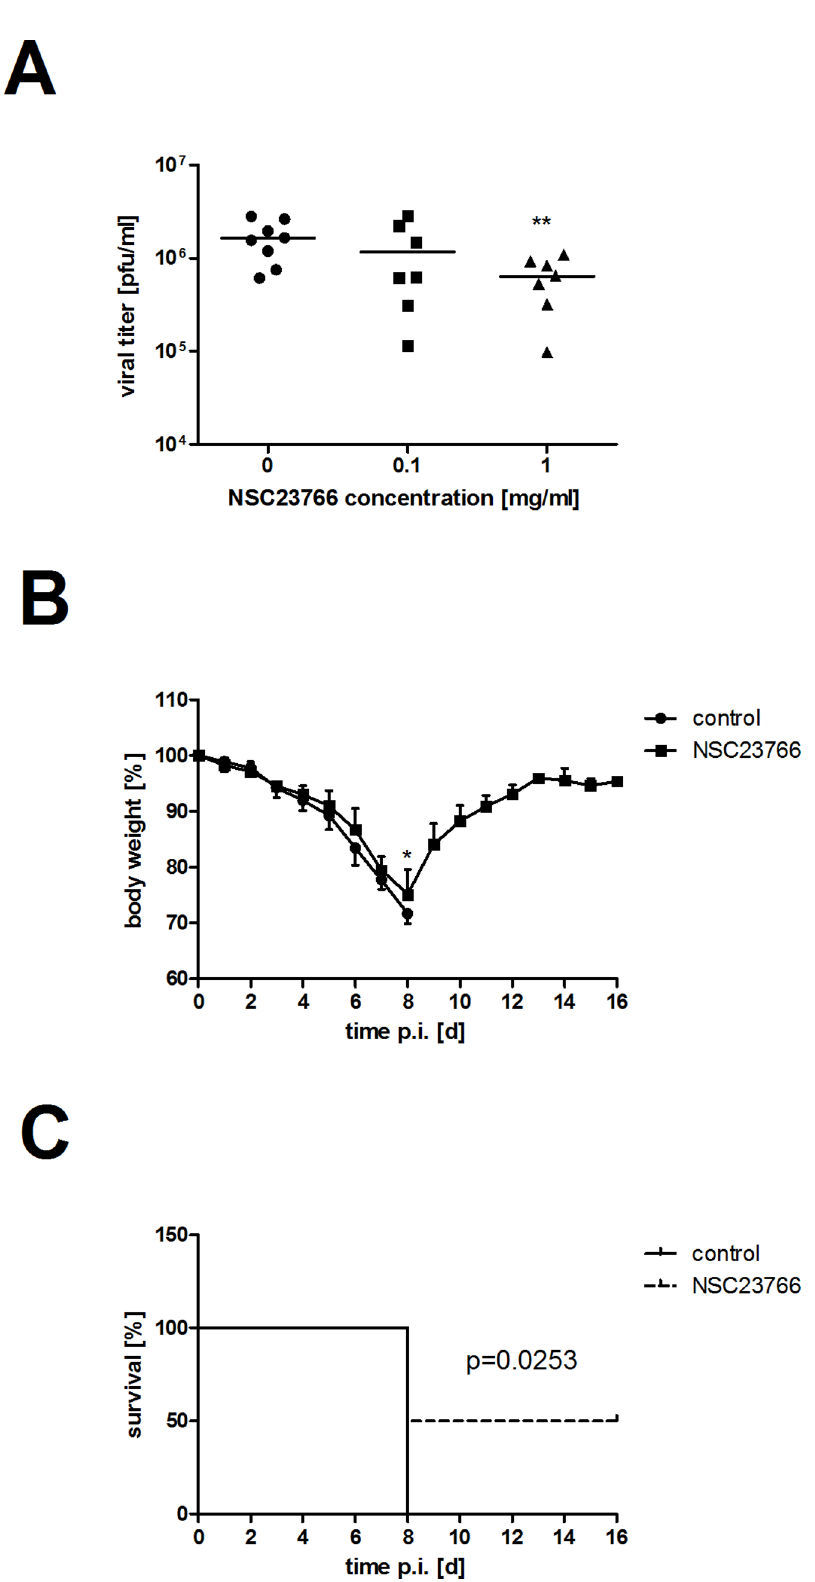
Figure 8. NSC23766 has an antiviral potential in mice. BALB/c mice were infected with A/Puerto-Rico/8/34 rec. (200 PFU (A) or 100 PFU (B)). Immediately after infection, treatment with nebulized NSC23766 was started (twice per day for 20 min with indicated concentrations). (A) Viral load in the lungs was determined at day three p.i. (control n=8, 0.1 mg/ml and 1 mg/ml n=7). (B–C) Infected mice were treated with NSC23766 (1 mg/ml) until day seven p.i and disease progression was monitored over a period of 16 days (n=8). Mice were humanly sacrificed when they lost 25% of their